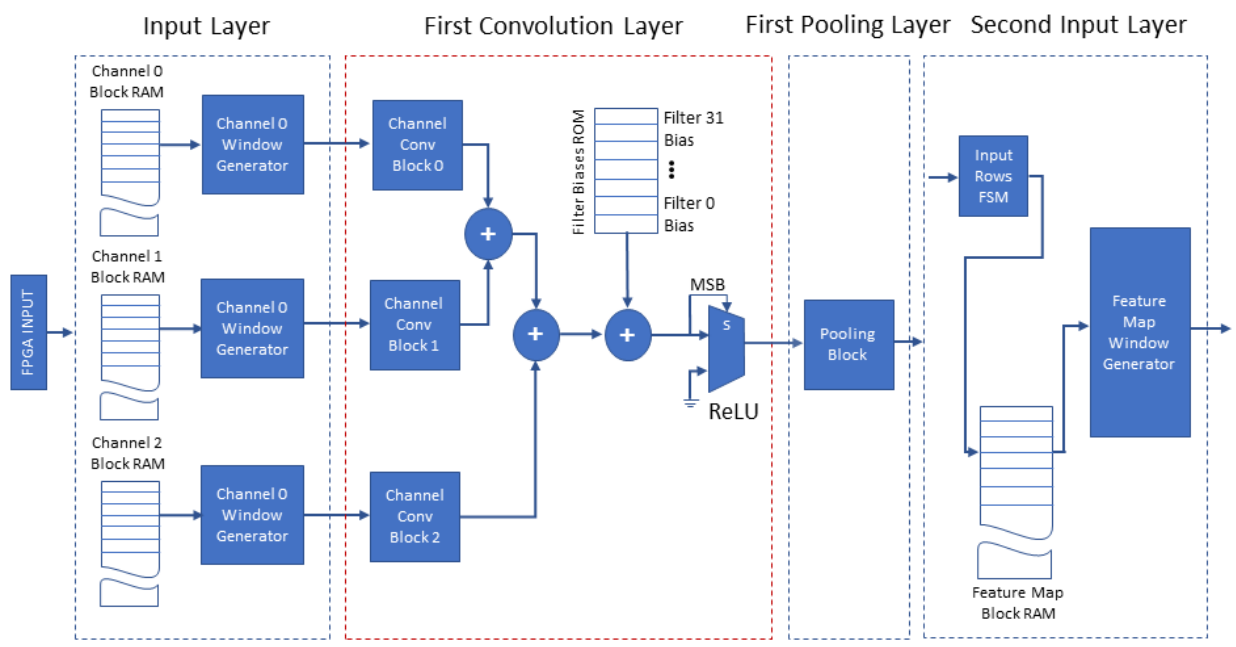
Figure 6. FPGA Architecture of the input layer, first convolution and pooling layers and the second input layer ( + refers to fixed-point integer